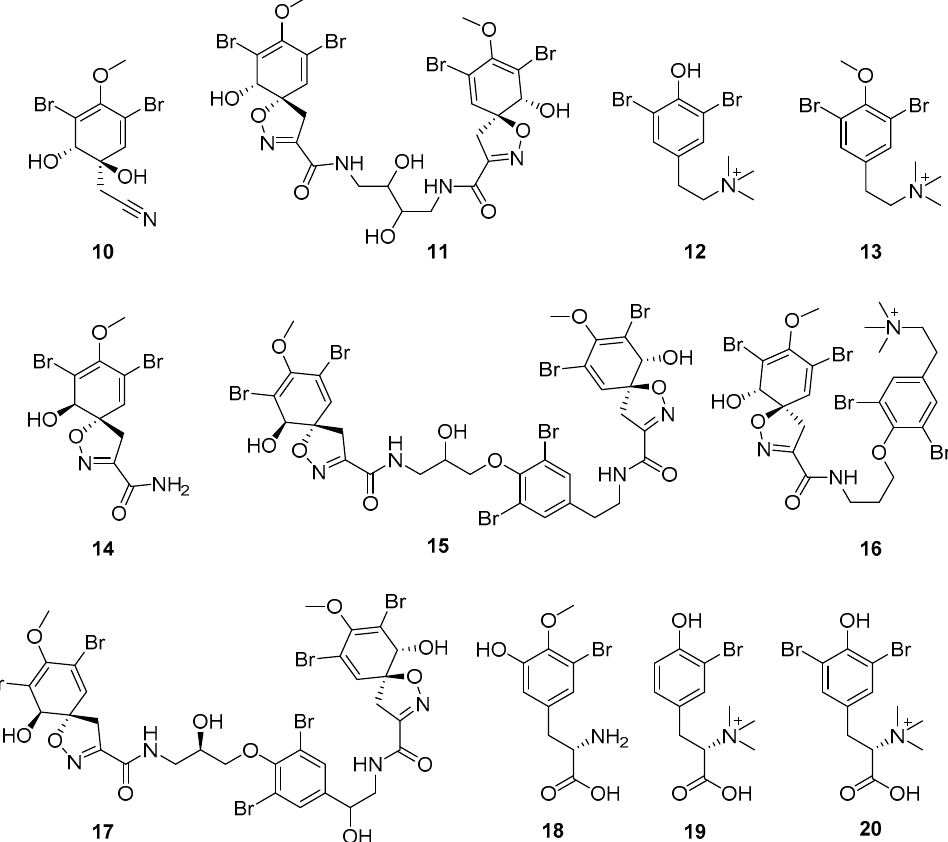
Figure 7. Structures of aeroplysinin-1 ( 10 ), dihydroxyaerothionin ( 11 ), 3,4-dibromo- N,N,N - trimethyltyraminium ( 12 ), 3,5-dibromo- N,N,N,O -tetramethyltyraminium ( 13 ), purealidin R ( 14 ), 19- deohxyfistularin 3 ( 15 ), purealidin B ( 16 ), fistularin-3 ( 17 ), 3-bromo-5-hydroxy- O -methyltyrosine ( 18 ), 3-bromo- N,N,N -trimethyltyrosinium ( 19 ), and 3,5-dibromo- N,N,N -trimethyltyrosinium ( 20 ).